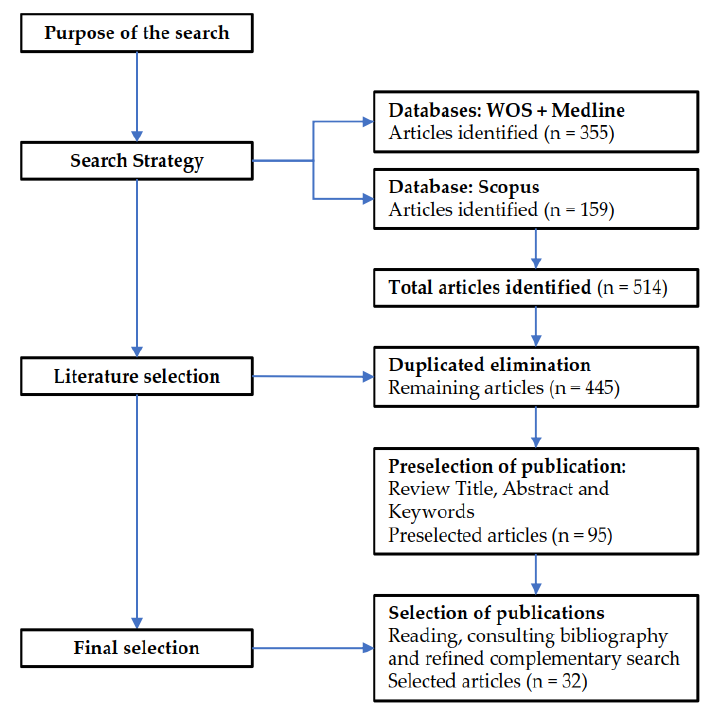
Figure 1. Literature review process.